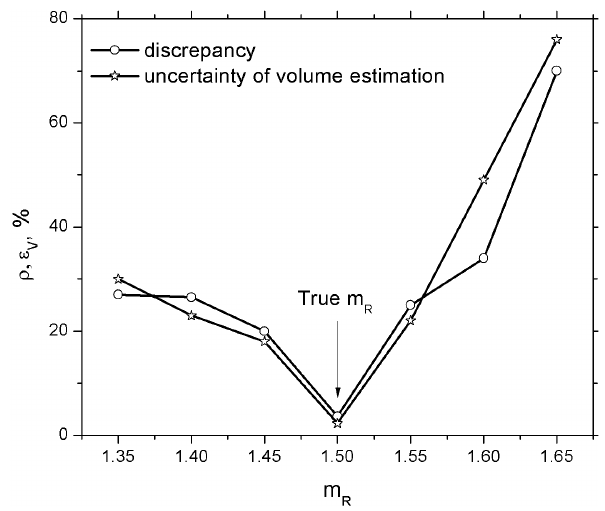
Fig. 1. Dependence of discrepancy ρ and uncertainty of particle vol- ume estimation ε V on the real part of refractive index. Simulation was performed for r 0 =1µm and m =1.5– i